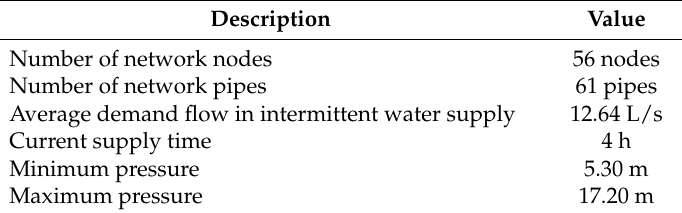
Table 2. Main network characteristics of the case study.